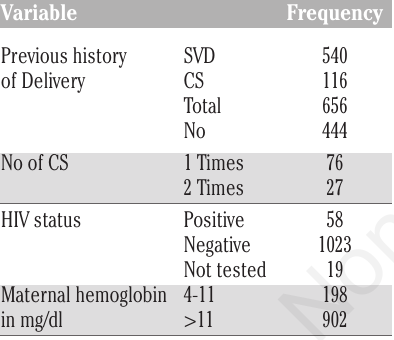
Table 7. Distribution of previous history of delivery, HIV status and hemoglobin level of participant at DBRH from January 2015 to December 2016.